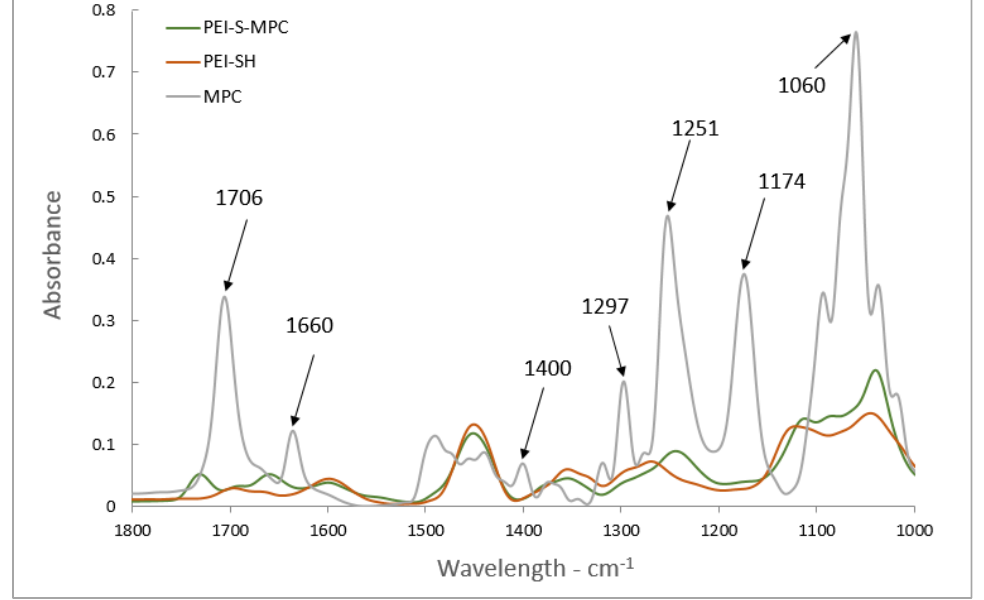
Figure 2. ATR-FTIR spectra of the coating complex (bPEI-S-MPC), bPEI-SH, and MPC reagent. Table 1. Atomic content in the coating complex, obtained by elemental analysis.